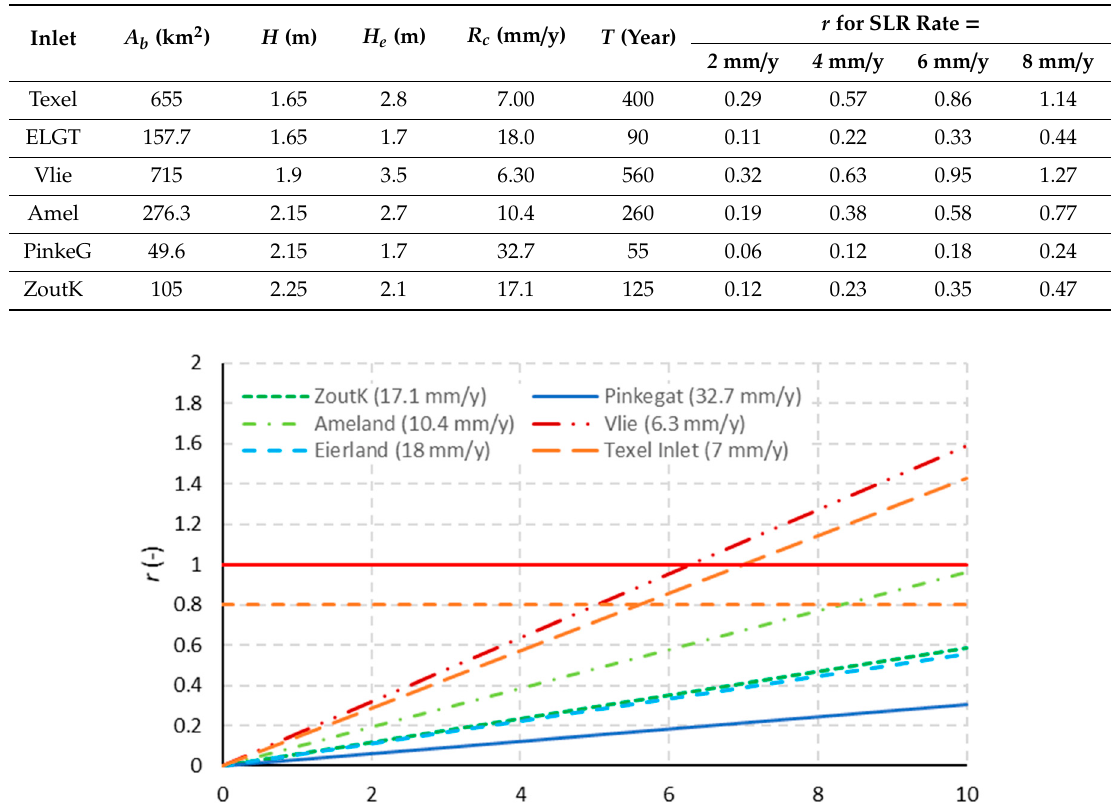
Table 1. Critical SLR rate for drowning of the various tidal inlet systems in the Dutch Wadden Sea from [21] and the dimensionless SLR rate r for four di ff erent SLR rates (2, 4, 6 and 8 mm / y). The equilibrium depth H e calculated using the empirical relations and the parameters for basin area A b and tidal range H are also given. The listed time scale T is calculated using the relation with R c and H e .